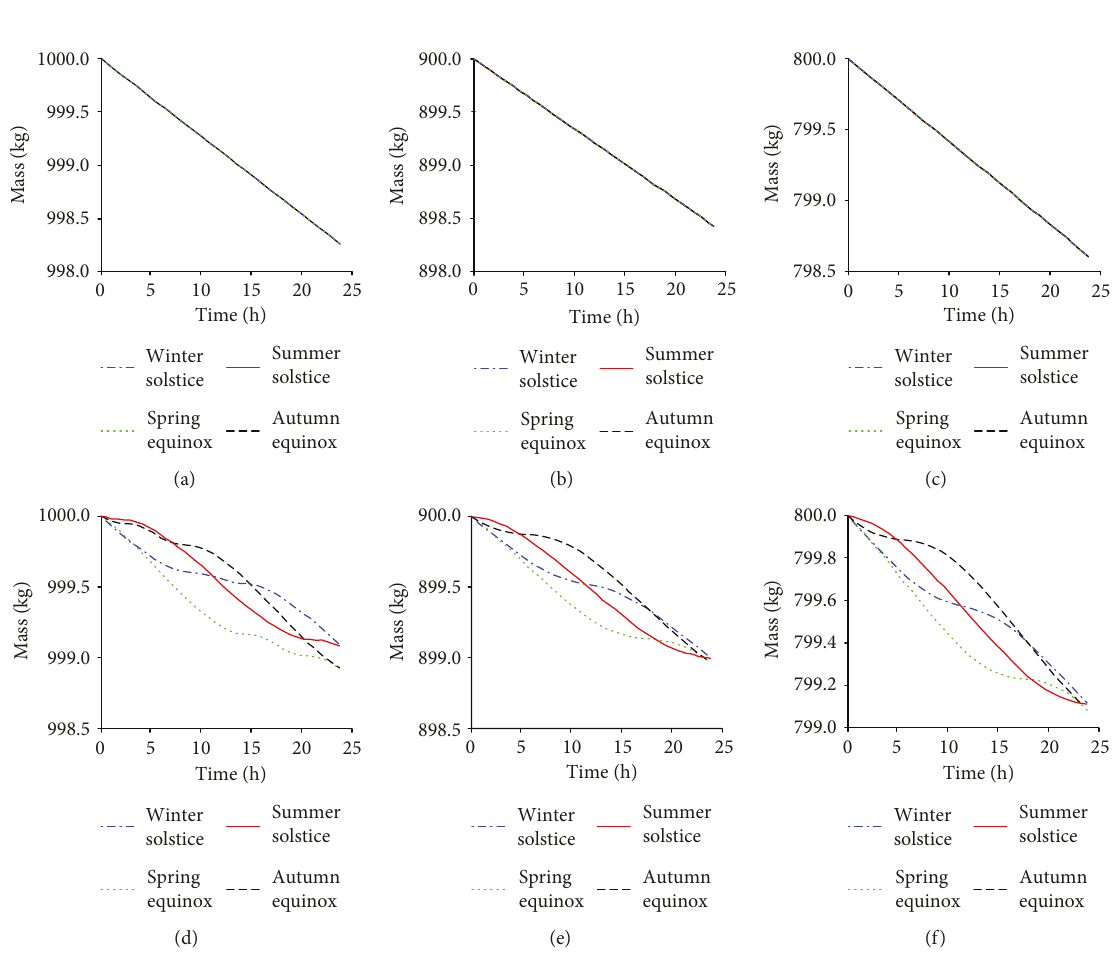
Figure 6: Strict formation on ideal displaced GEO: mass of pure SEP (a) leader, (b) follower 1, and (c) follower 2 and mass of hybrid sail (d) leader, (e) follower 1, and (f) follower 2 in the frame (A).